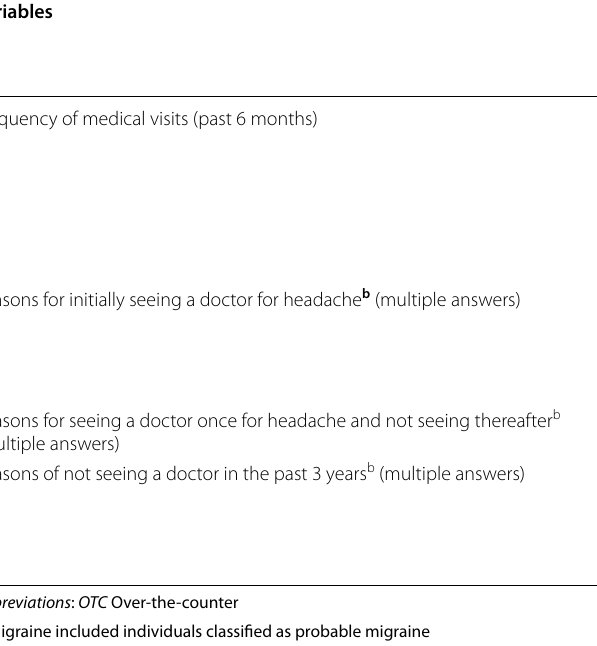
a Migraine included individuals classified as probable migraine